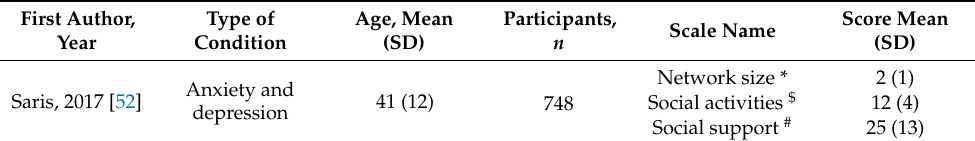
Table 8. Social functioning